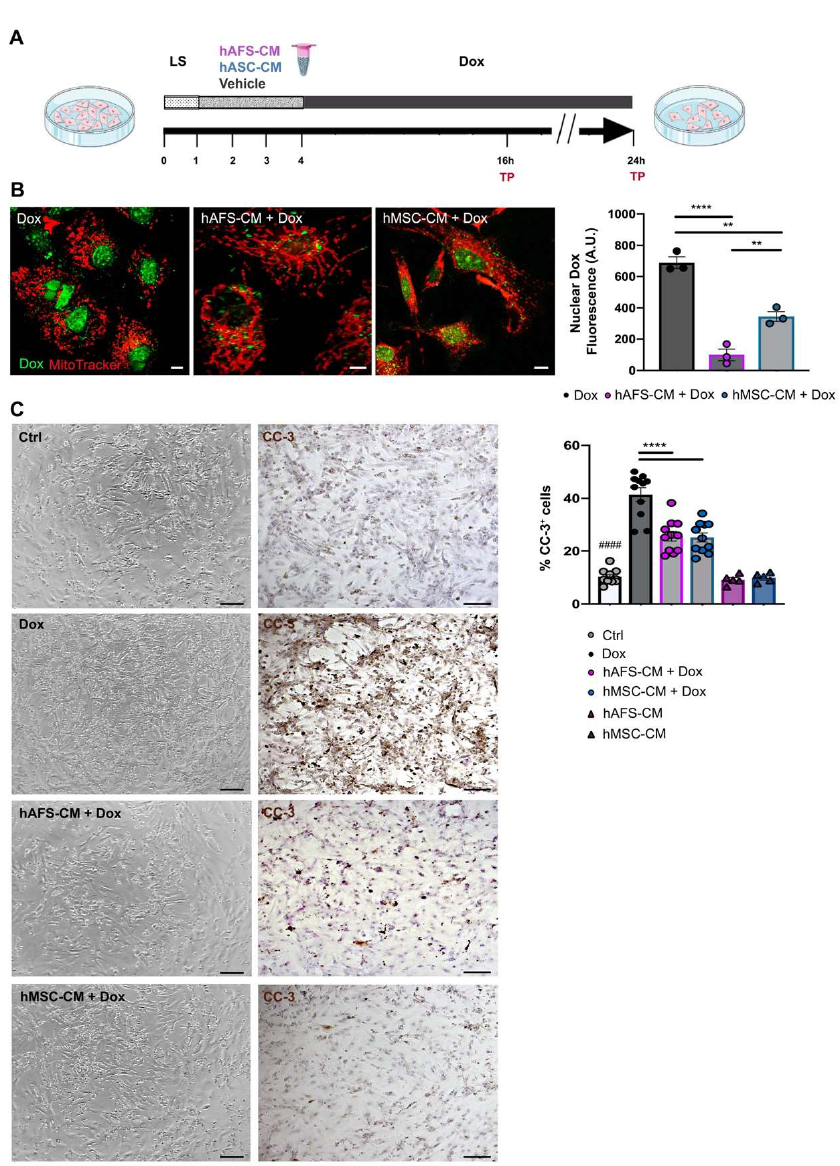
Figure 1. hAFS and hMSC secretome formulations exert cardioprotective effects on mNVCM exposed to Dox. ( A ) Schematic of the experimental design for in vitro experiments. ( B ) Left panel: representative confocal images of live mNVCM exposed to 1 µ M Dox for 16 h with or without ( Dox ) prior priming with hAFS-CM ( hAFS-CM + Dox ) or hMSC-CM ( hMSC-CM + Dox ) for 3 h. Mitochondria are represented in red by the MitoTracker signal; Dox nuclear localization is represented in green by means of the drug auto-fluorescent signal, scale bar: 5 µ m. Right panel: evaluation of Dox nuclear fluorescence by arbitrary units ( A.U. ) in Dox-exposed mNVCM ( Dox : 689.67 ± 37.19 ) versus mNVCM primed with either hAFS-CM ( hAFS-CM + Dox : 99.33 ± 36.22 ; **** p < 0.0001) or hMSC-CM ( hMSC-CM + Dox : 345.33 ± 31.15 ; ** p = 0.0011). Values are expressed as the mean ± s.e.m. of n = 3 independent experiments. hAFS-CM + Dox vs hMSC-CM + Dox ** p = 0.0060. ( C ) Left panel: representative brightfield microscopy images and immunocytochemistry analysis of the cleaved-caspase 3 enzyme ( CC-3 ) on untreated mNVCM ( Ctrl ) and on mNVCM exposed for 21 h to 1 µ M Dox with or without ( Dox ) previous priming with hAFS-CM ( hAFS-CM + Dox ) or hMSC-CM ( hMSC-CM + Dox ) for 3 h, scale bar: 20 µ m. Left panel: percentage of mNVCM expressing cleaved-caspase-3 ( %CC-3 + cells ) in control condition ( n = 11, Ctrl: 10.35 ± 0.80% ), after either hAFS-CM ( n = 5, hAFS-CM: 9.24 ± 0.84% ) or hMSC-CM ( n = 5, hMSC-CM: 10.01 ± 0.76% ) stimulation alone or after exposure to Dox with or without ( n = 11, Dox: 41.43 ± 2.50% ) pre-incubation with hAFS-CM ( n = 11, hAFS-CM+Dox: 25.67 ± 1.83% ) or hMSC-CM ( n = 11, hMSC-CM + Dox: 25.16 ± 1.72% ). Values are expressed as the mean ± SEM of the independent experiments; hAFS-CM vs. Ctrl and hMSC-CM vs. Ctrl : not significant; Ctrl vs. Dox; #### p < 0.0001; hAFS-CM + Dox vs Dox and hMSC-CM + Dox vs. Dox **** p <